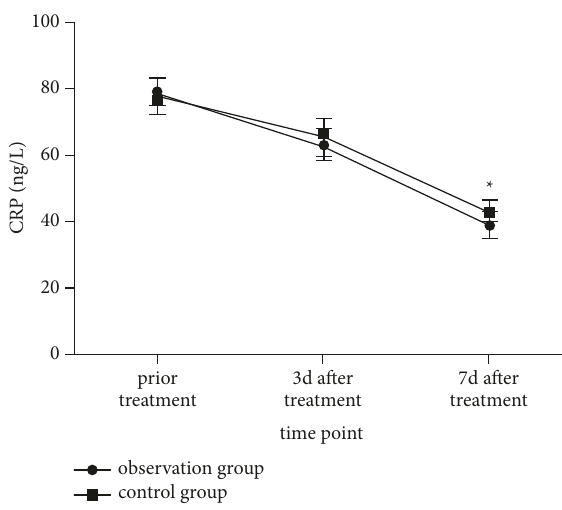
Figure 11: Comparison of CRP between the two groups before and after treatment.